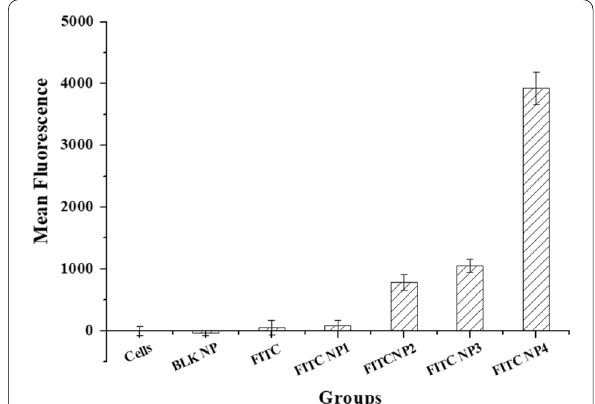
Fig. 4 Cell cytotoxicity of the BSA-loaded nanoparticles in the A549 cell line